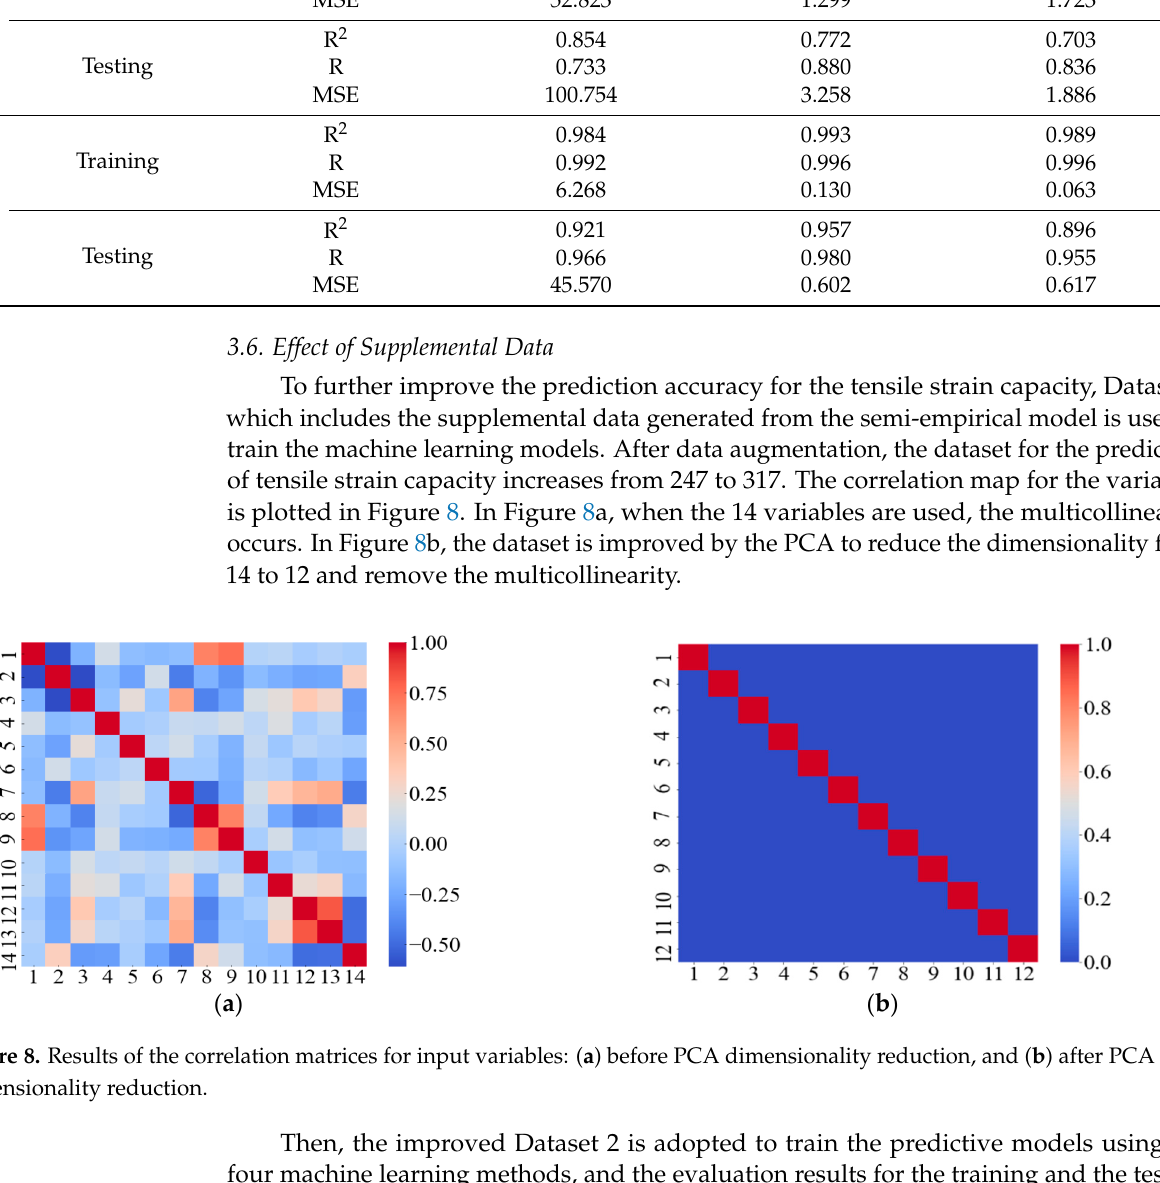
Table 6. Evaluation of prediction results using enlarged dataset.